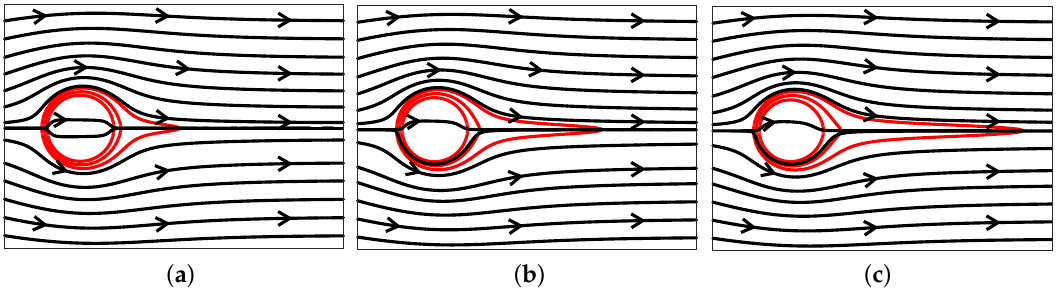
Figure 4. Streamline distribution in the vicinity of a circular blob for R = 10 at ( a ) t = 40, ( b ) t = 70 and ( c ) t = 100 seconds. The red lines are the concentration contours at concentration levels 0.05, 0.08 and